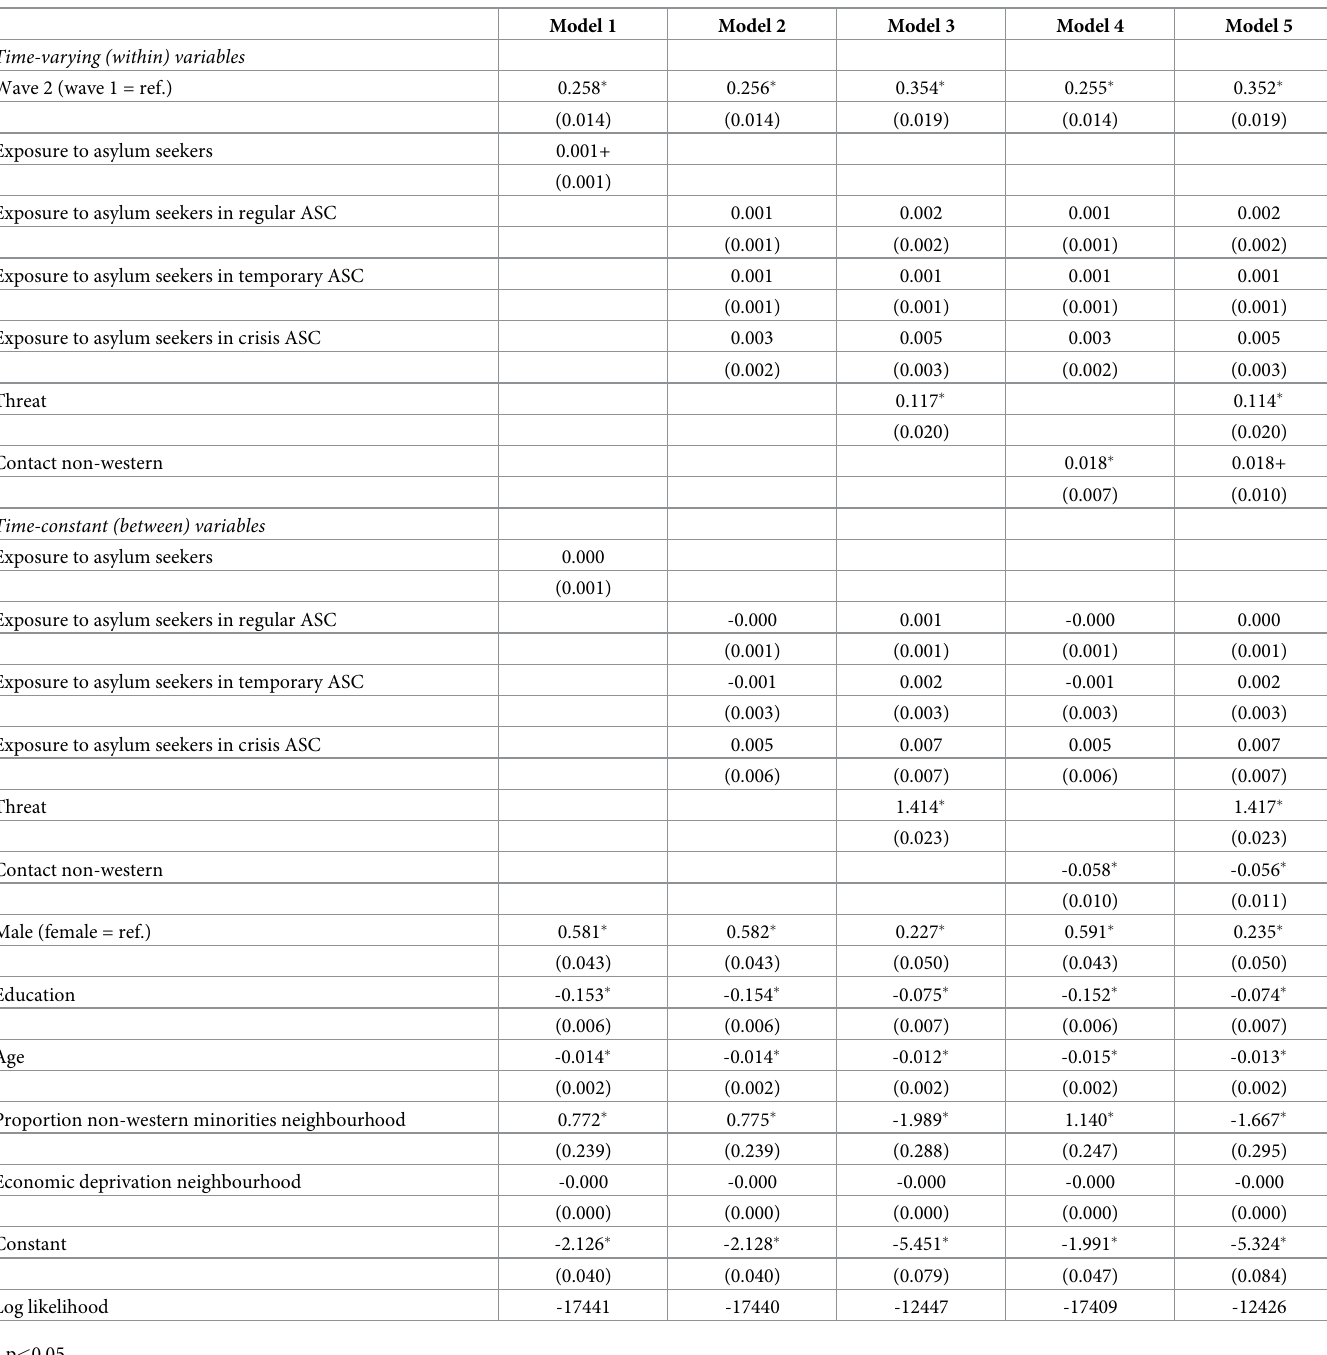
Table 3. Hybrid models predicting voting intention for the PVV (standard errors in parentheses; N i = 19,091; N nb =